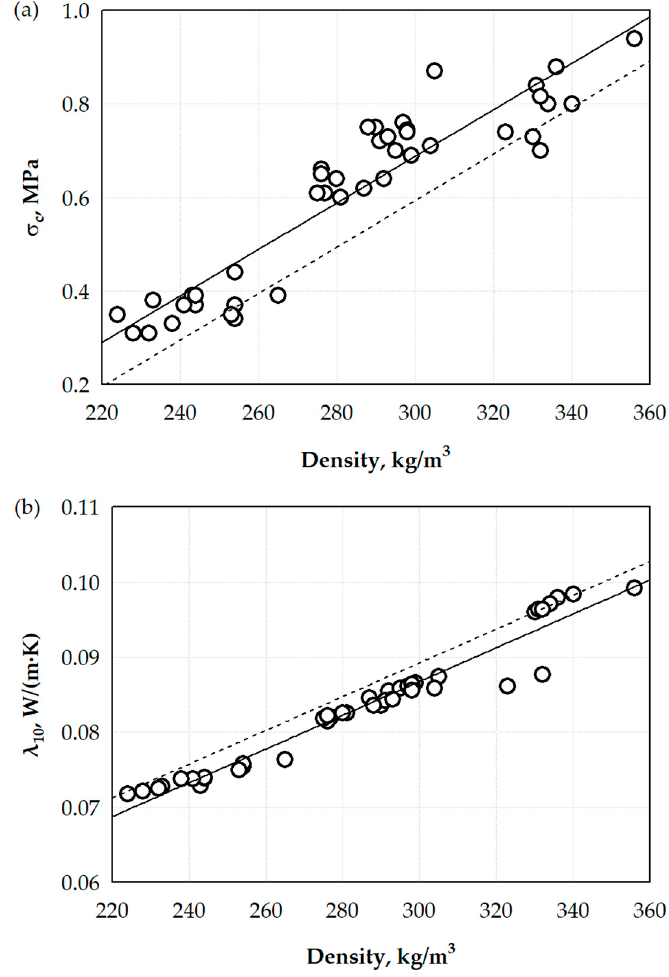
Figure 2. Dependencies of compressive strength ( a ) and thermal conductivity ( b ) on the density of the LWC; ○ —experimental values.